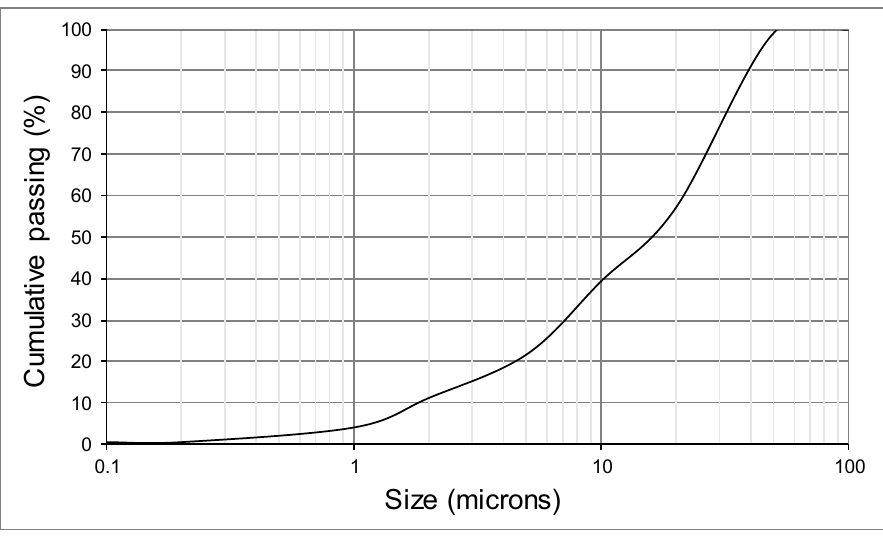
Figure 2. Particle size distribution.